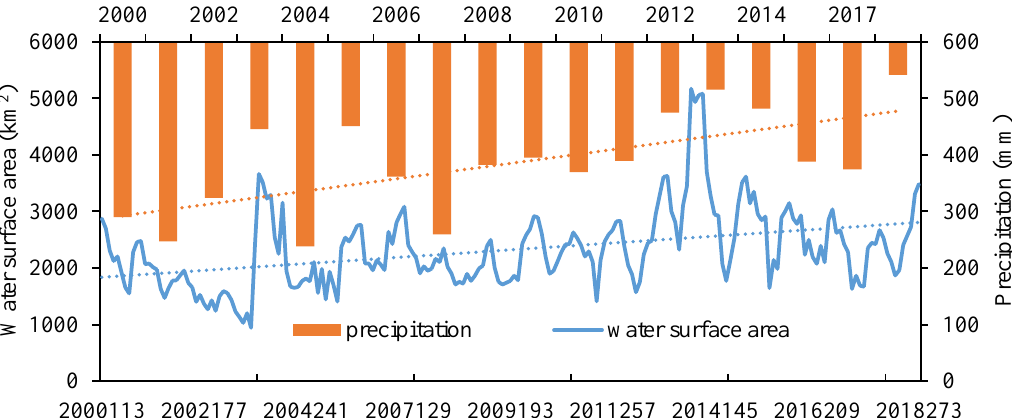
Figure 7. Time series of total open water surface area each 16 days (blue) and annual precipitation (orange) in the Nenjiang River Basin, Northeast China, from 2000 to 2018.